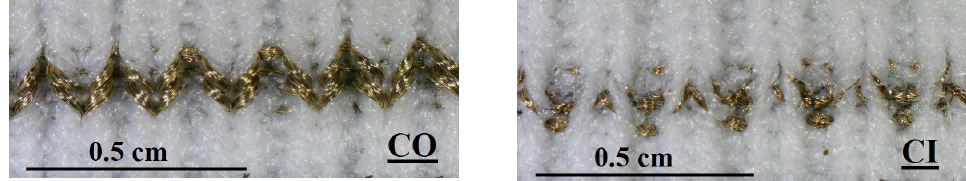
Figure 8. The yarn configuration of two samples ( a ) NP 9 Y S 1 C 2 E 1 CO and ( b ) NP 9 Y S 1 C 2 E 1 CI. The comparison of NP 9 Y S 1 C 2 E 1 CO and NP 9 Y S 1 C 2 E 1 CI samples in terms of electrome-